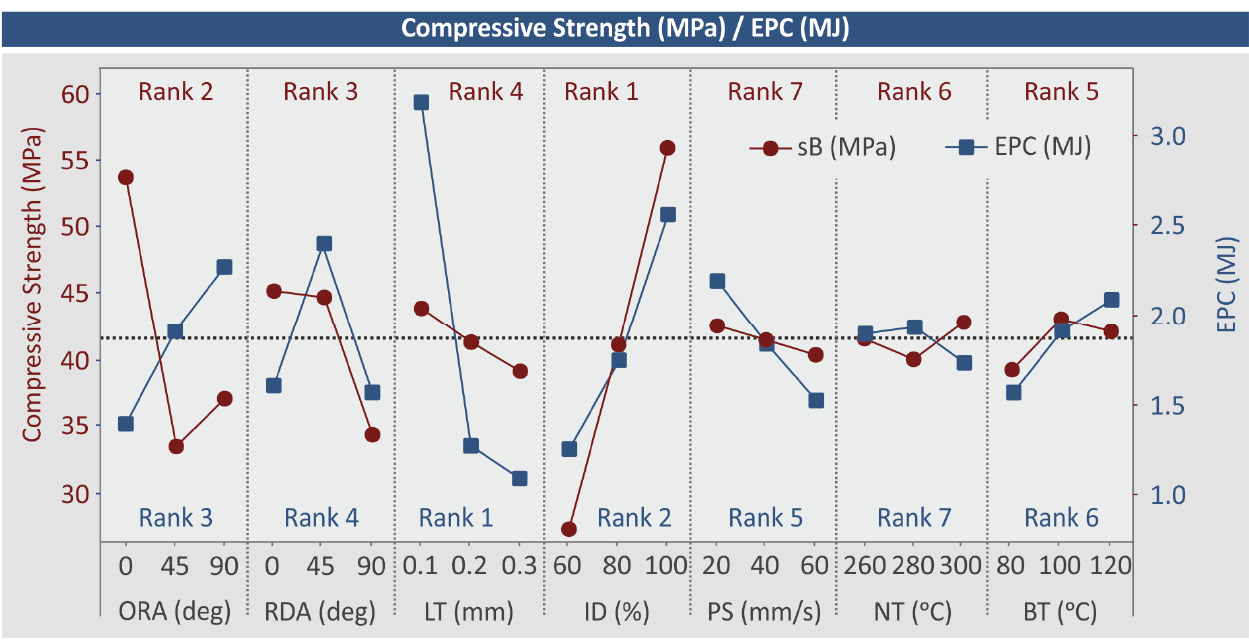
Figure 8. MEP for the printing time (s) and the part weight (g) vs. the control parameters of this work.